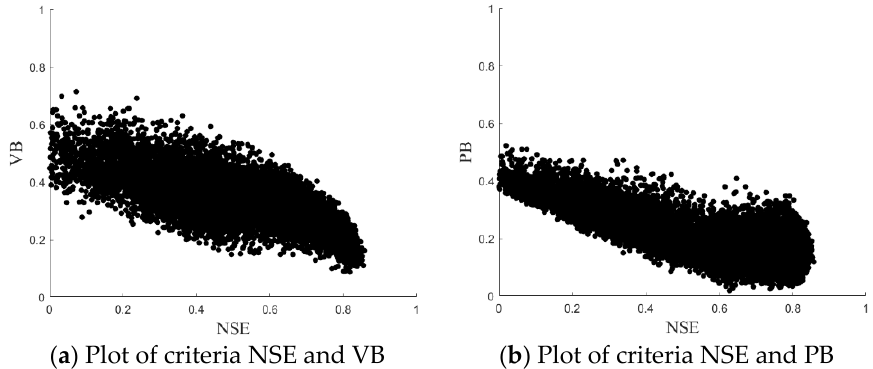
( a ) Plot of criteria NSE and VB ( b ) Plot of criteria NSE and PB Figure 6. Relationship between different criteria. Figure 6. Relationship between di ff erent